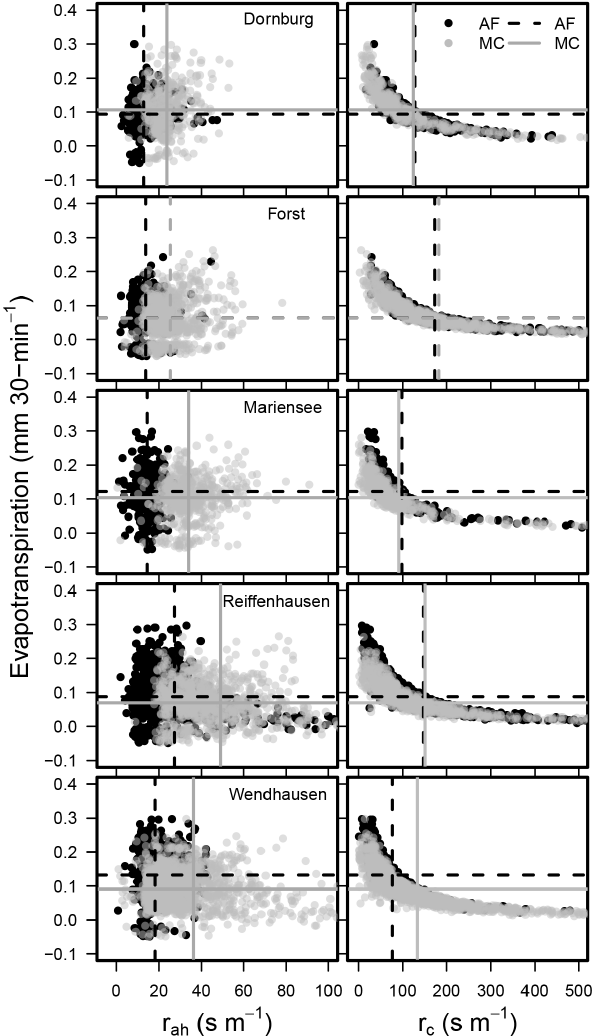
Figure 12. Half-hourly ET EC-LC vs. aerodynamic resistance ( r ah ; left) and canopy resistance ( r c ; right) for all sites. The dashed grey line corresponds to the mean aerodynamic and canopy resistance and evapotranspiration at the AF system, and the dashed black line corresponds to the mean aerodynamic and canopy resistance and evapotranspiration at the MC system at the specific site. Only data corresponding to ideal ambient conditions are shown, e.g. global ra- diation ( R G ≥ 400Wm − 2 ), wind speed ( u ≥ 1ms − 1 ), and vapour pressure deficit ( D = 1 ± 0 . 3kPa; Schmidt-Walter et al.,